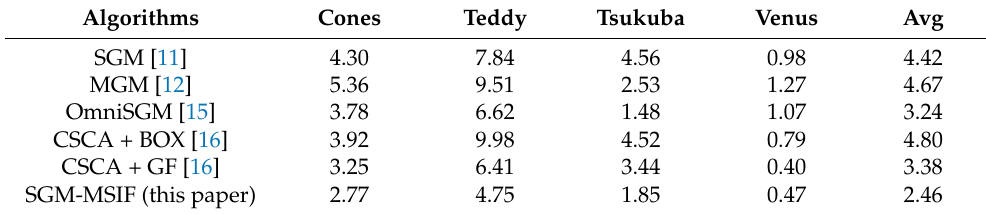
Table 2. Comparison of EMRs in Non-occ regions of six algorithms (%).